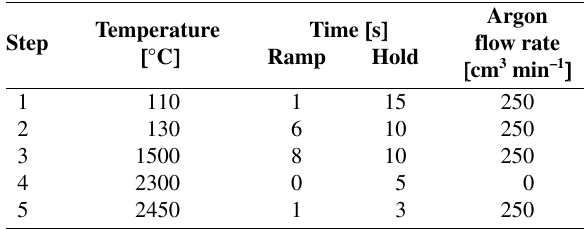
Figure 1. The new extraction cell